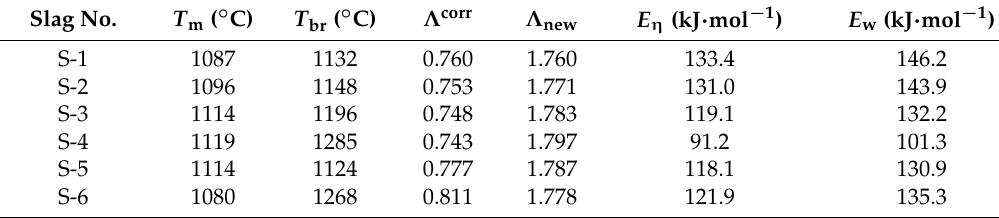
Table 2. Melting temperature ( T m ), break temperature ( T br ), corrected optical basicity ( Λ corr ), new optical basicity ( Λ new ), and viscous activation energy of experimental slags. Slag No. T m ( ◦